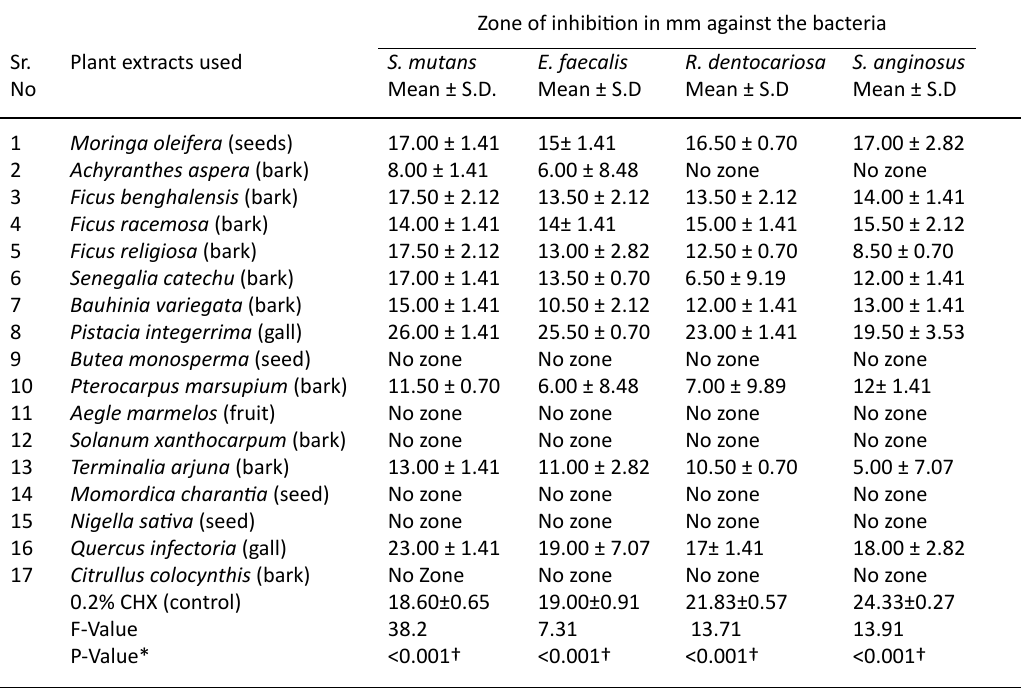
Table 2. Antimicrobial activity (zone of inhibition, mm) of various plant extracts against isolated oral pathogens